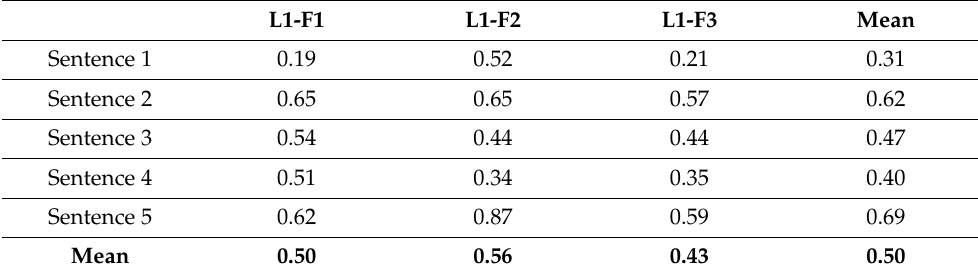
Table 7. Average deviations of group L1-F from their own group